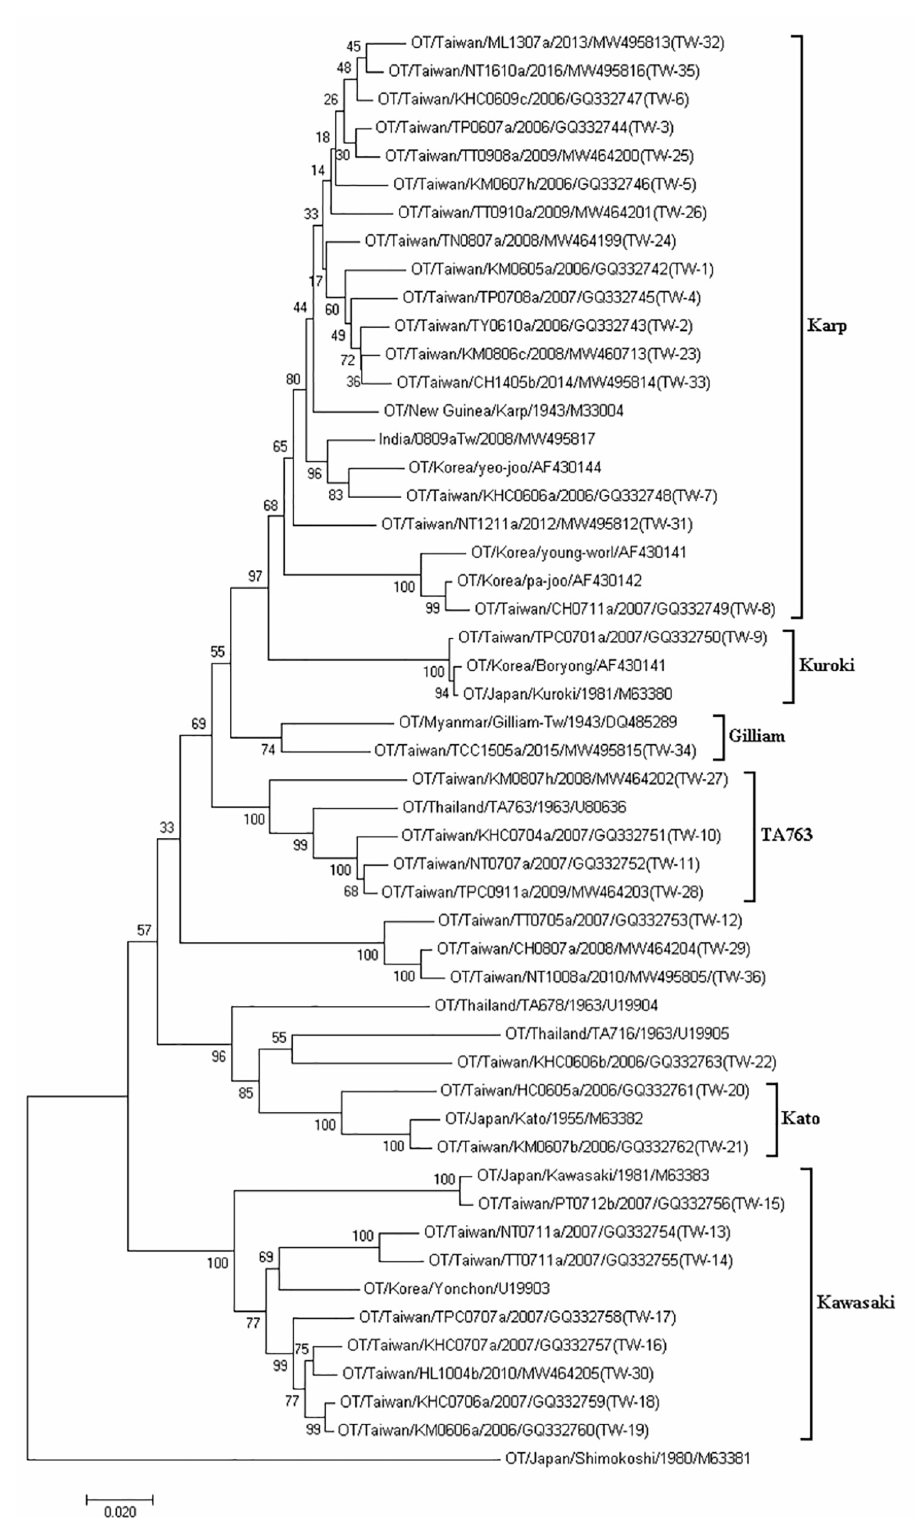
Fig 5. Phylogenetic tree based on the 56 kDa TSA gene ORF of TW-1 to TW-36.